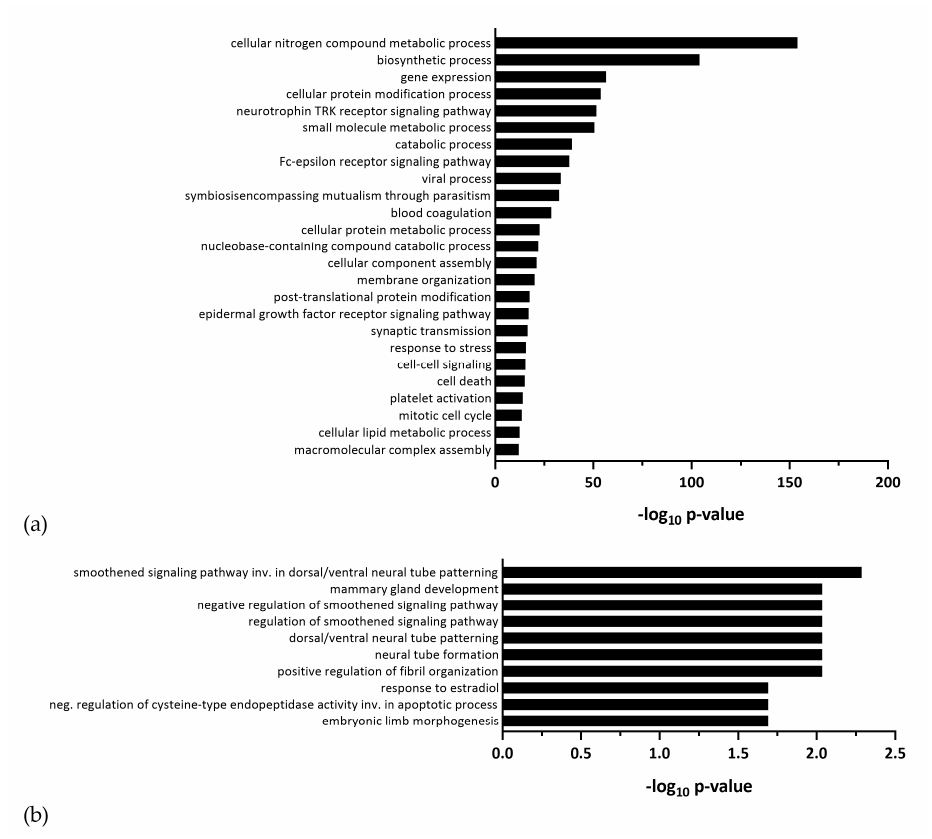
Figure 6. Gene ontology (GO) analysis of potential target genes of differentially expressed miRNAs. ( a ) GO analysis of biological processes of putative targets of miRNAs which were dysregulated in lt-NES ® cells during infection with ZIKV Polynesia and Uganda. ( b ) GO analysis of biological processes of putative targets of miR-7704, which was upregulated by ZIKV Polynesia and Uganda.